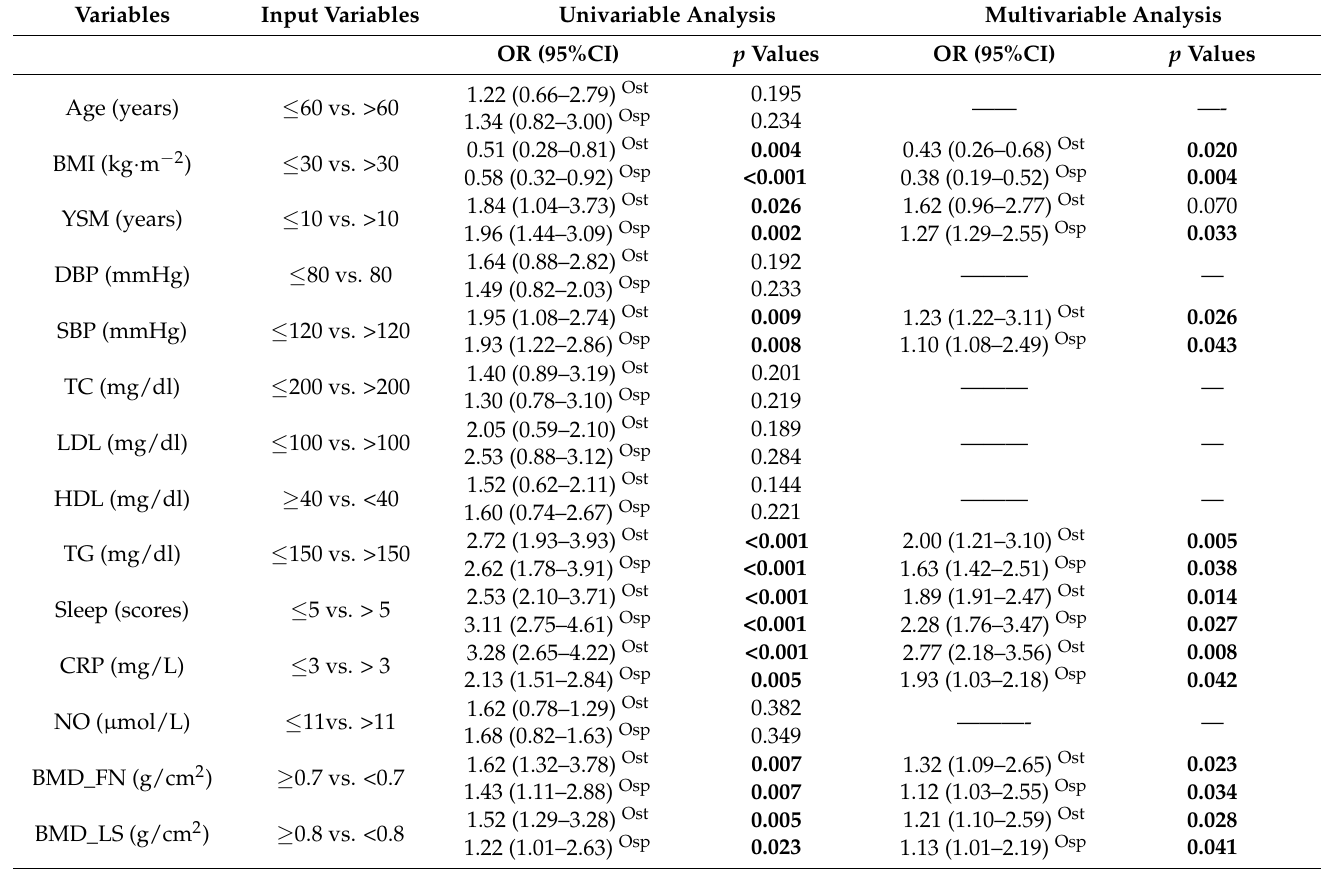
Table 2. Independent predictors for the risk of osteoporosis and